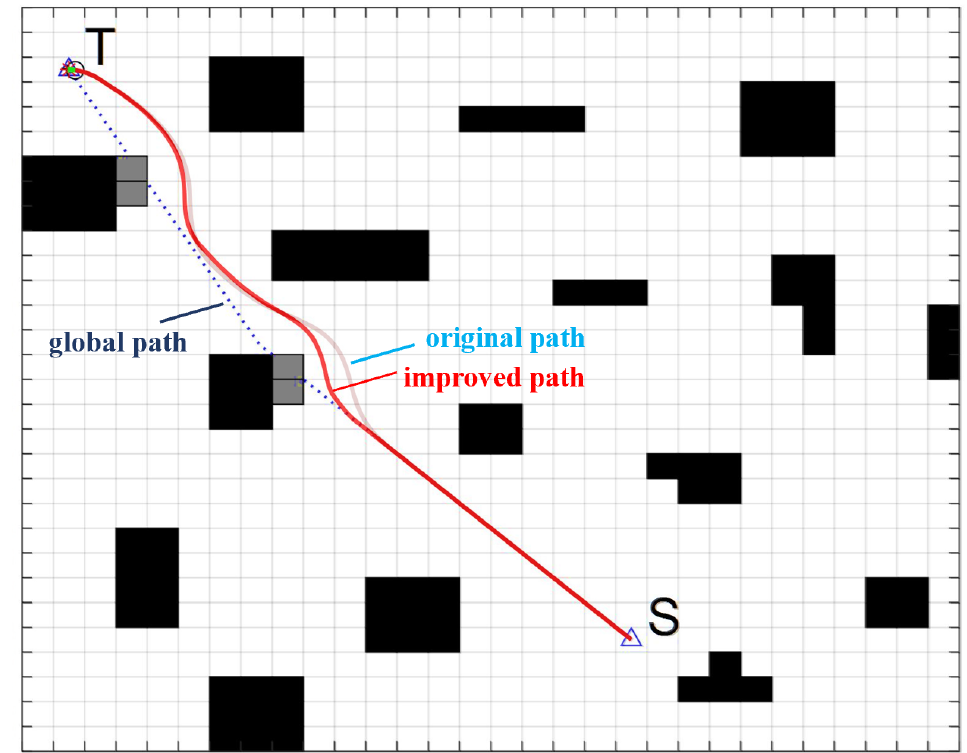
Figure 9. Comparison of local paths before and after improvement of the evaluation function.